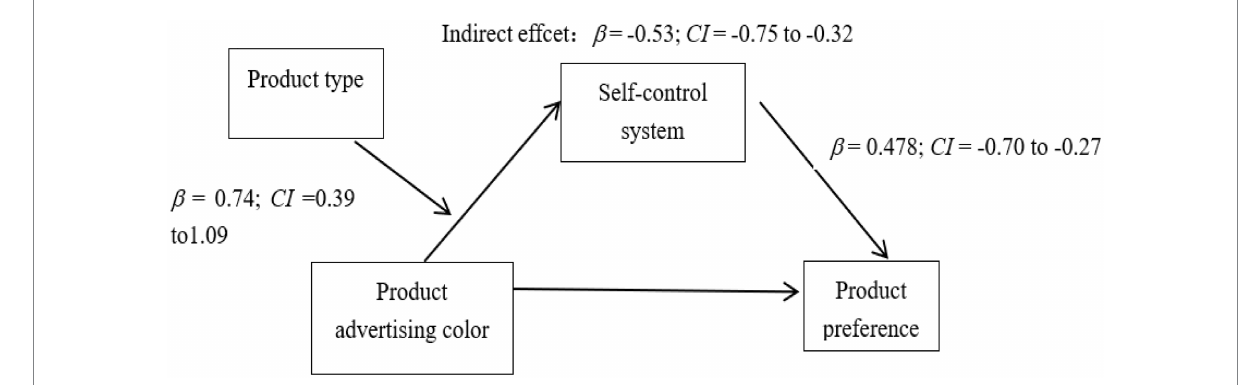
FIGURE 2 The Moderating Role of Product Type.